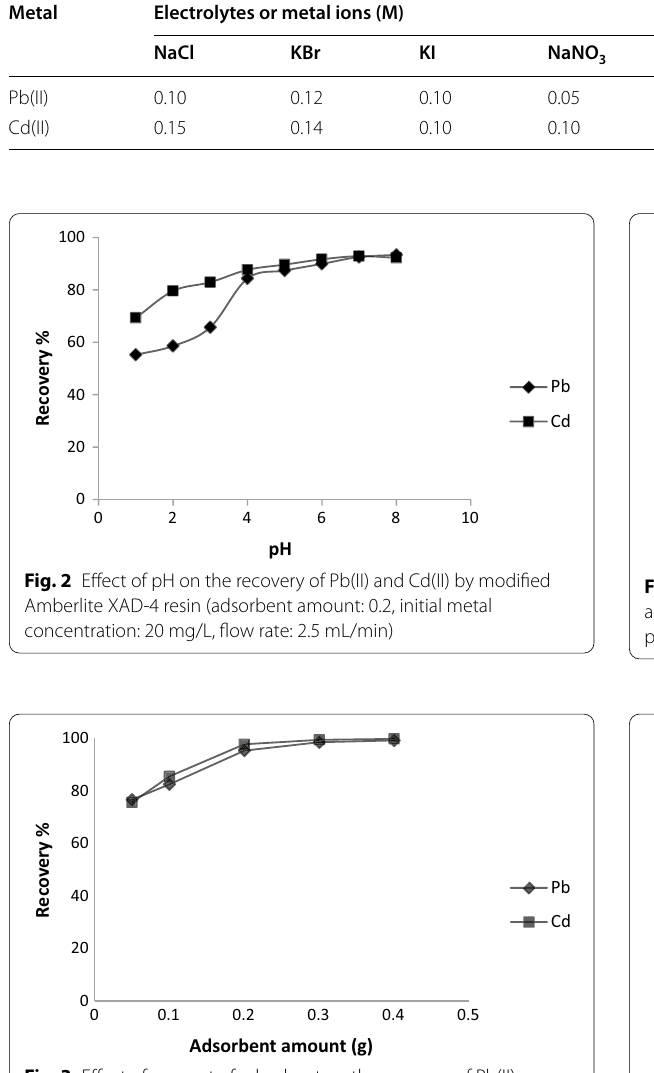
Fig. 5 Effect of flow rate on the recovery of Pb(II) and Cd(II) by modified Amberlite XAD-4 resin (adsorbent amount: 0.2, pH:5, initial metal concentration: 20